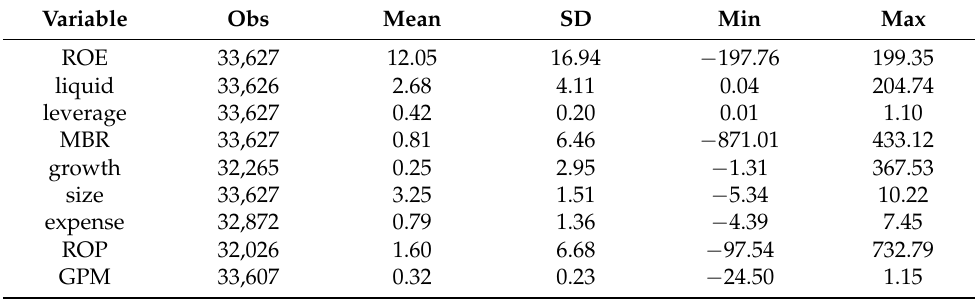
Table 2. Descriptive